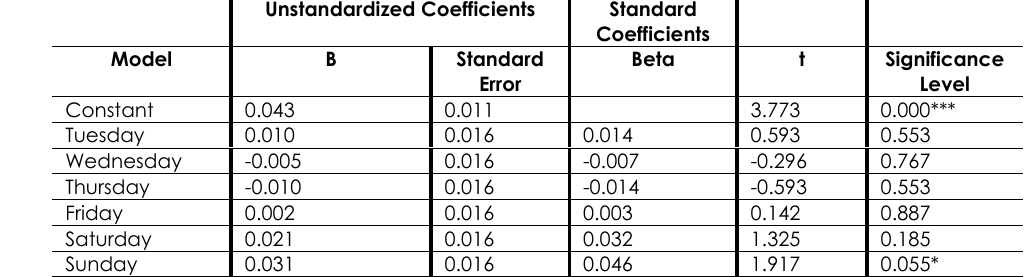
Table 11. Table of coefficients in the model established to determine whether there is a day effect on